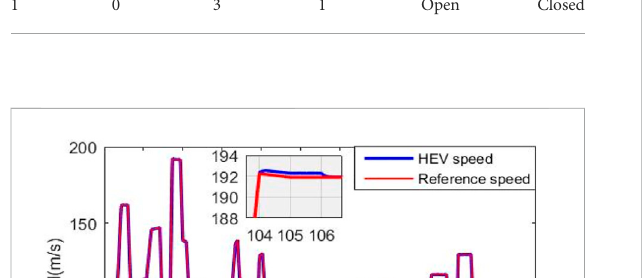
FIGURE 12 HEV torque